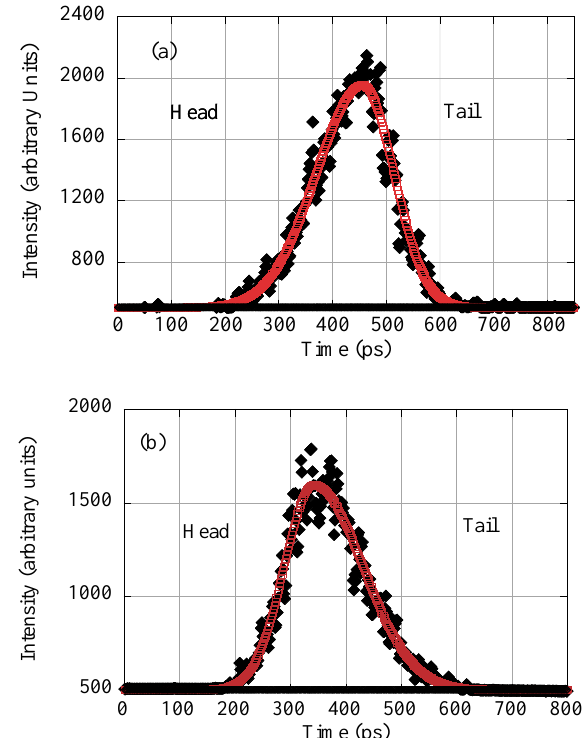
FIG. 17. (Color) Two single streak camera distributions fit to an asymmetric Gaussian function where the asymmetry factor and time deviation between bunches is (a) d As 31 (cid:1) 0.2 and d t